Question: Generate an informative caption for the figure above.
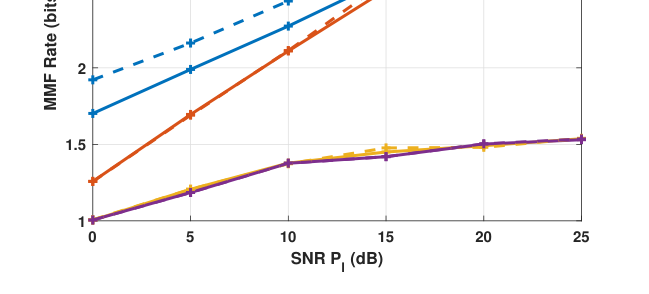
Answer: MMF rate versus LEO SNR Pl for different GEO SNR Pg and network loads. Ntg = 4, Ntl = 3, M = 2, N = 6, K = 8.